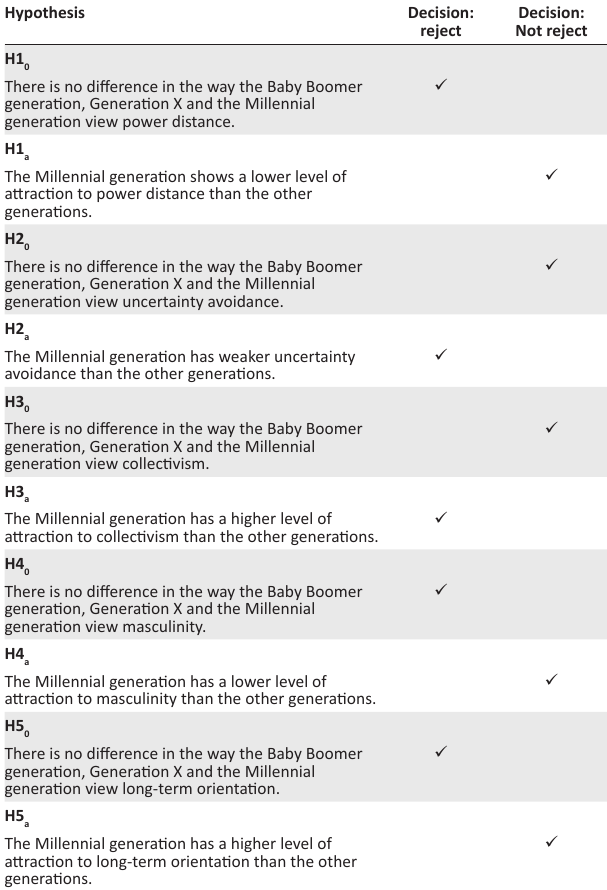
TABLE 8: Differences found in relation to hypotheses